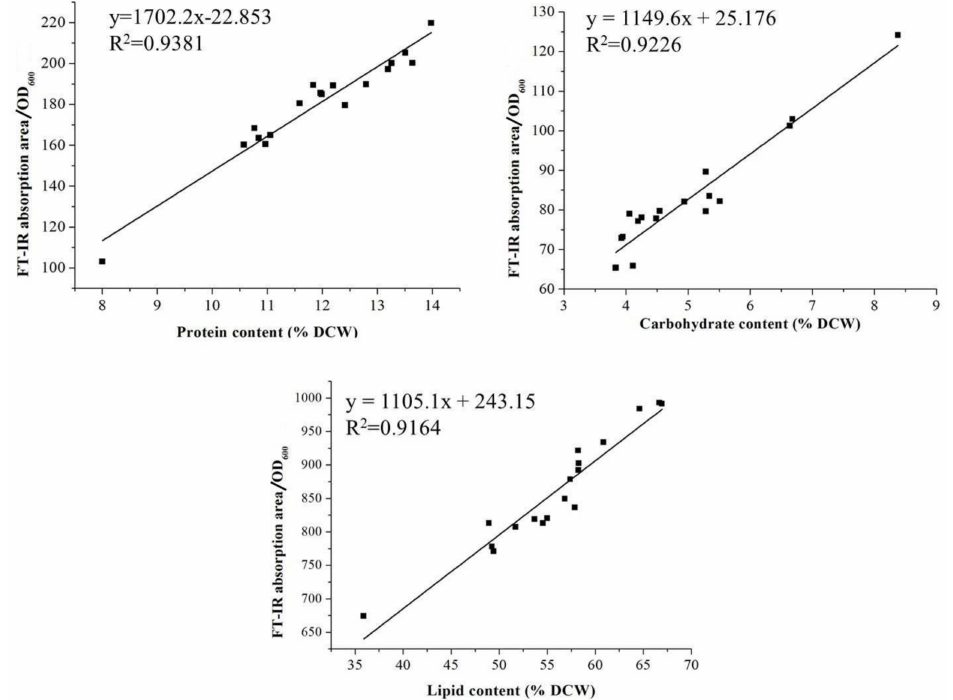
Figure 3. Linear correlations between the results deduced by the traditional and the FT-IR methods for the contents of the main three bio-macromolecules in Aurantiochytrium sp.